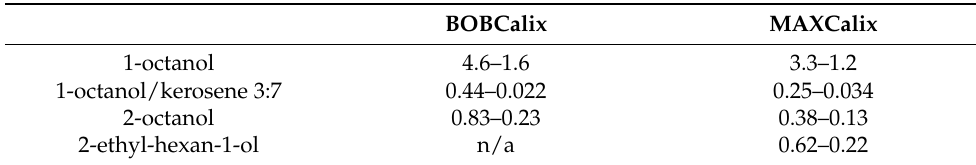
Table 2. Cs + distribution ratios for the extraction from 4 M NaCl or 0.4 M NaCl by BOBCalix and MAXCalix in several diluents. Organic phase, 0.01 M BOBCalix or MAXCalix. Aqueous phase, (4 M